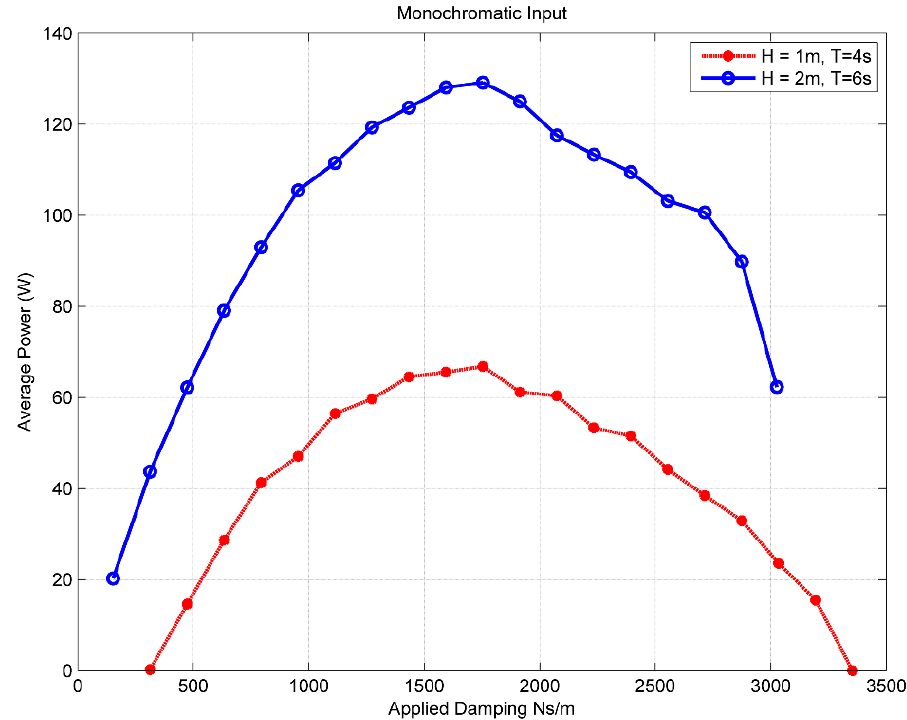
Figure 10. Average Power vs. Damping for two monochromatic wave